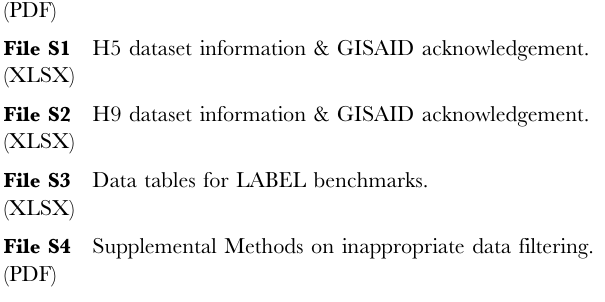
Figure S3 Phylogenetic tree of H9 HA with annotated clades and strain names. (PDF) Figure S4 Phylogenetic tree showing H5 outlier group 1.1-like . (PDF) Figure S5 Phylogenetic tree showing H5 outlier group 3-like . (PDF) Figure S6 LABEL benchmark versus alignment with 200 guide sequences. (PDF) Figure S7 Clustering of new H5s relative to old clades, pHMM scores vs. p-distance. (PDF) File S1 H5 dataset information & GISAID acknowledgement. (XLSX) File S2 H9 dataset information & GISAID acknowledgement.